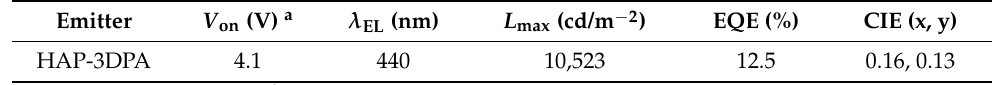
Figure 4. ( a ) The OLED structure. ( b ) The EL spectra at various current densities. ( c ) The current efficiency-voltage- luminance ( J - V - L ) characteristics. ( d ) EQE as a function of current density. Table 2. Summary of the OLED performance based on HAP-3DPA. Table 2. Summary of the OLED performance based on